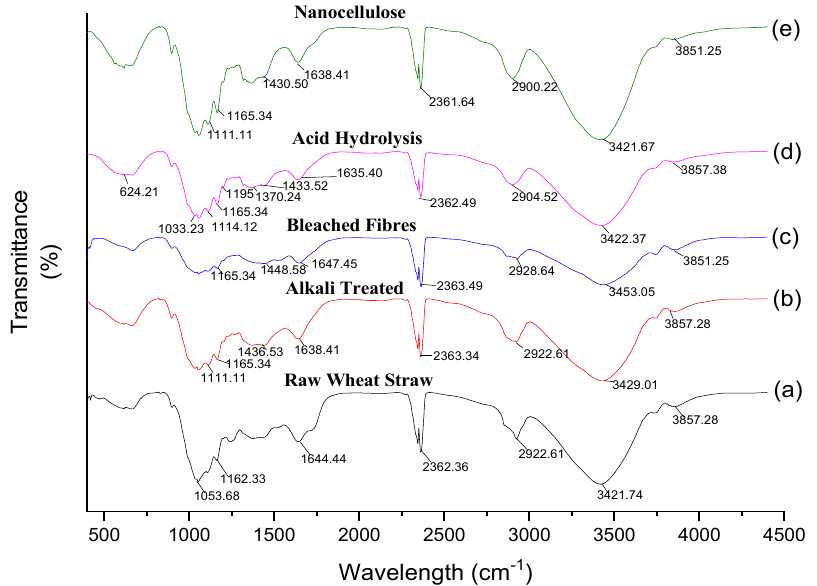
Fig. 3. FTIR spectra of (a) Raw Wheat straw, (b) Alkali treated, (c) Bleached fibres, (d)Acid hydrolysis and (e)